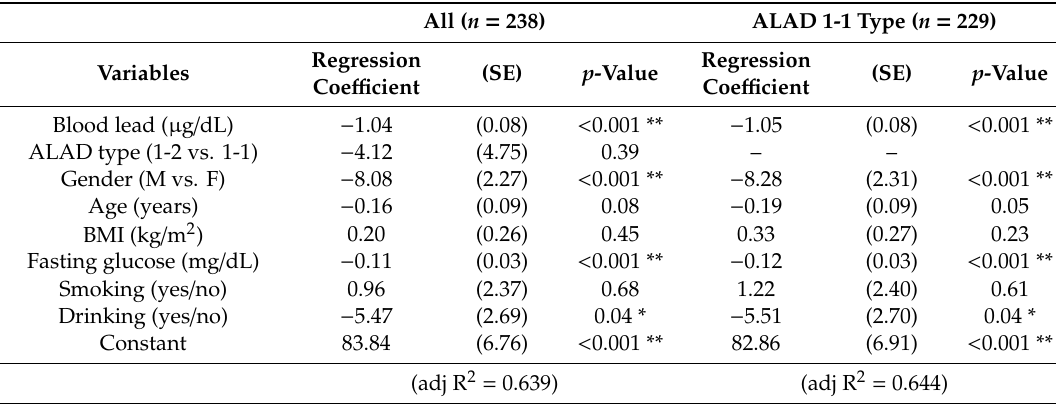
Table 2. Multiple linear regression model for ALAD